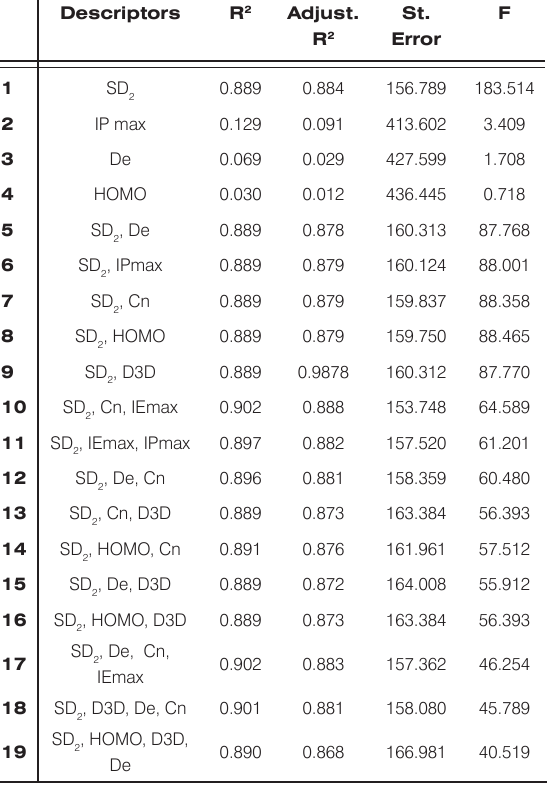
Table 8. Best models in describing LD50 in the training set of caffeine in Table 1.